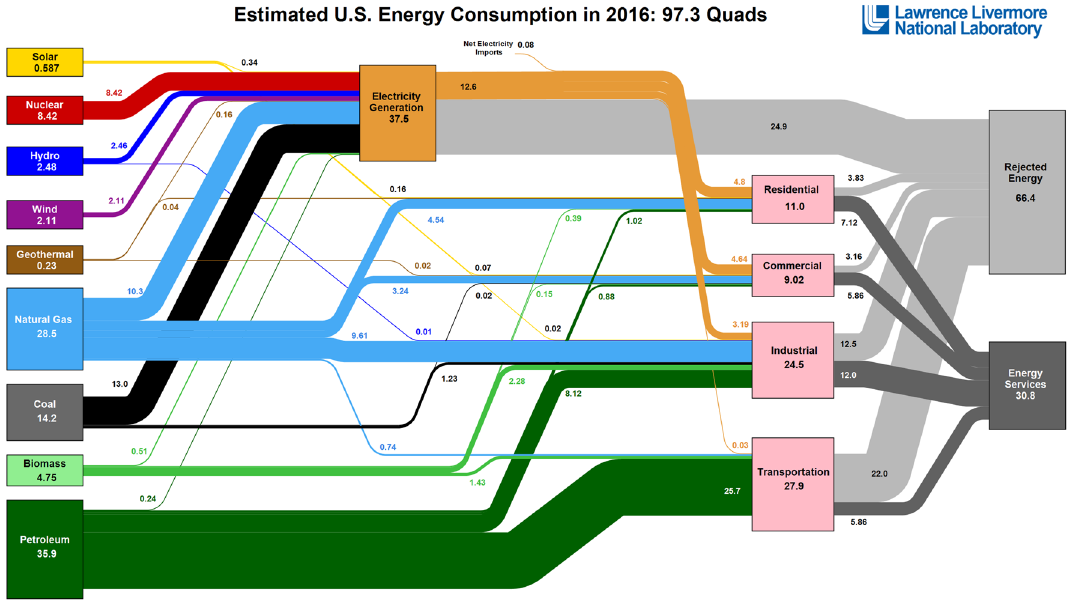
Figure 1. 2016 Energy flow Chart for the USA. This figure is not covered by the CC BY license. (Lawrence Livermore National Labs) 14 . All rights reserved, used with